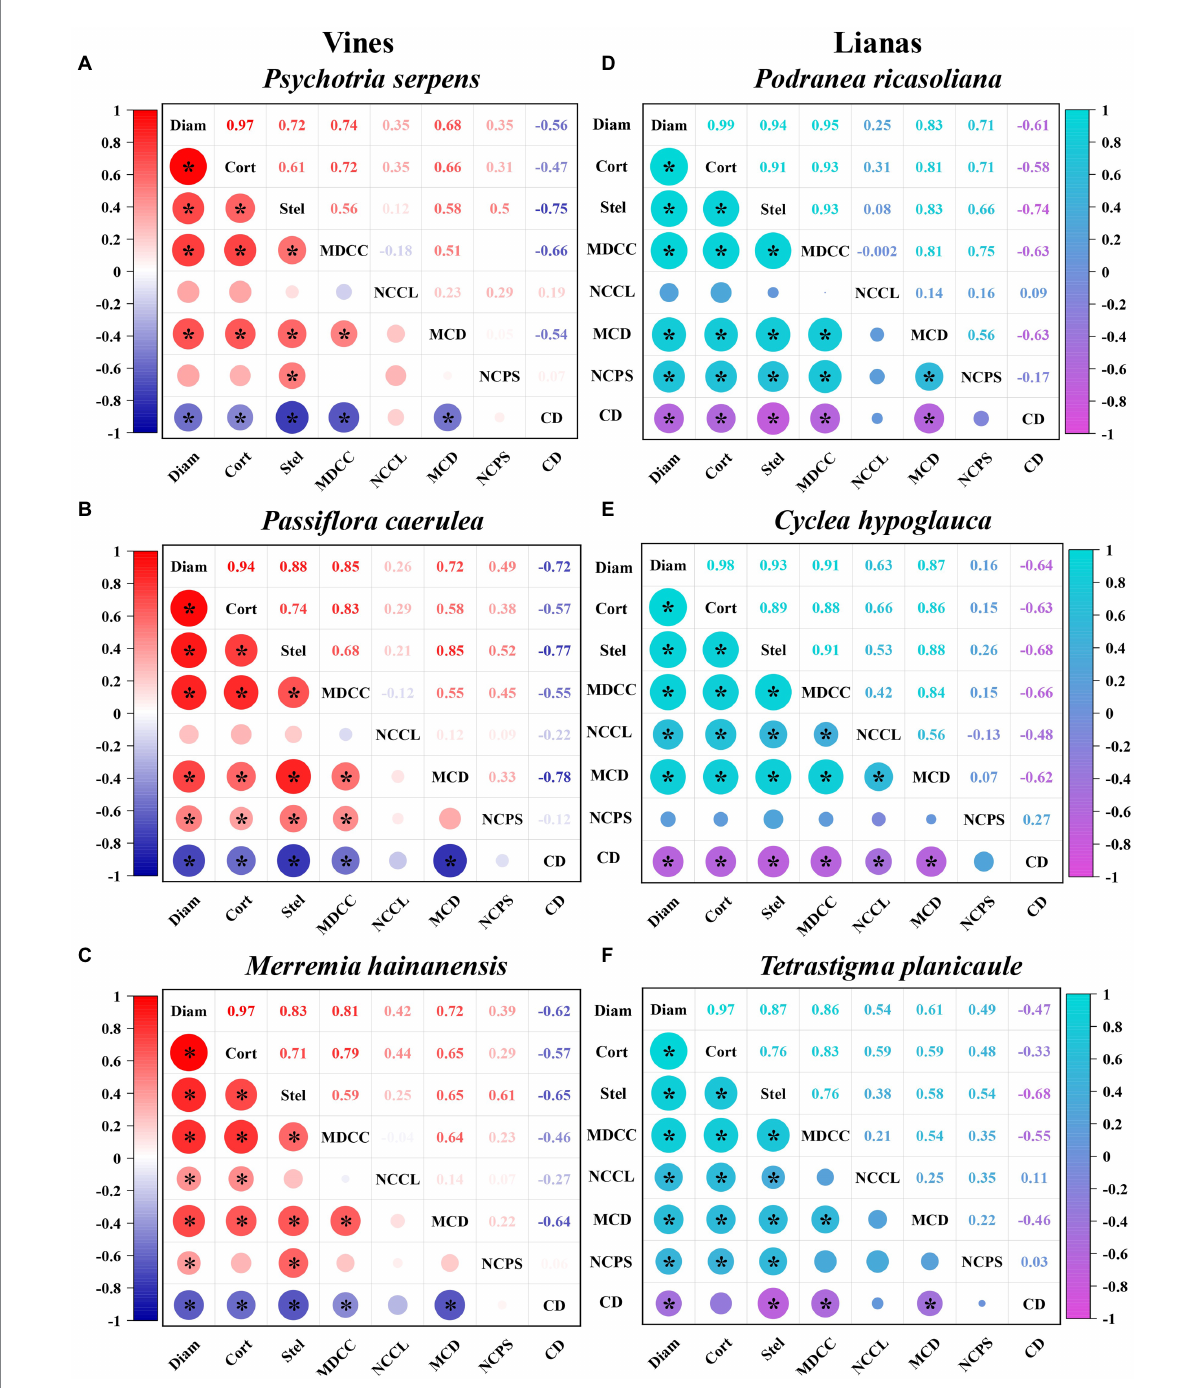
FIGURE 3 Intraspecific correlations of root tip diameter with cortex thickness, stele diameter, and cortical cells and conduit traits in three vine (A-C) (herbaceous climbing plants) and three liana (D-F) (woody climbing plants) species in tropical forest ( n = 30). Color intensity represents the strength of the correlation, figures represent Pearson’s correlation coefficients ( r ), and significant correlations ( p < 0.05) are indicated by “*”. See Supplementary Tables S2, S3 for adjusted regression coefficients ( R 2 ). Diam: root diameter; Cort: cortex thickness; Stel: stele diameter; MDCC: mean diameter of cortical cell; NCCL: number of cortical cell layer; MCD: mean conduit diameter; NCPS: number of conduits per stele; CD: conduit